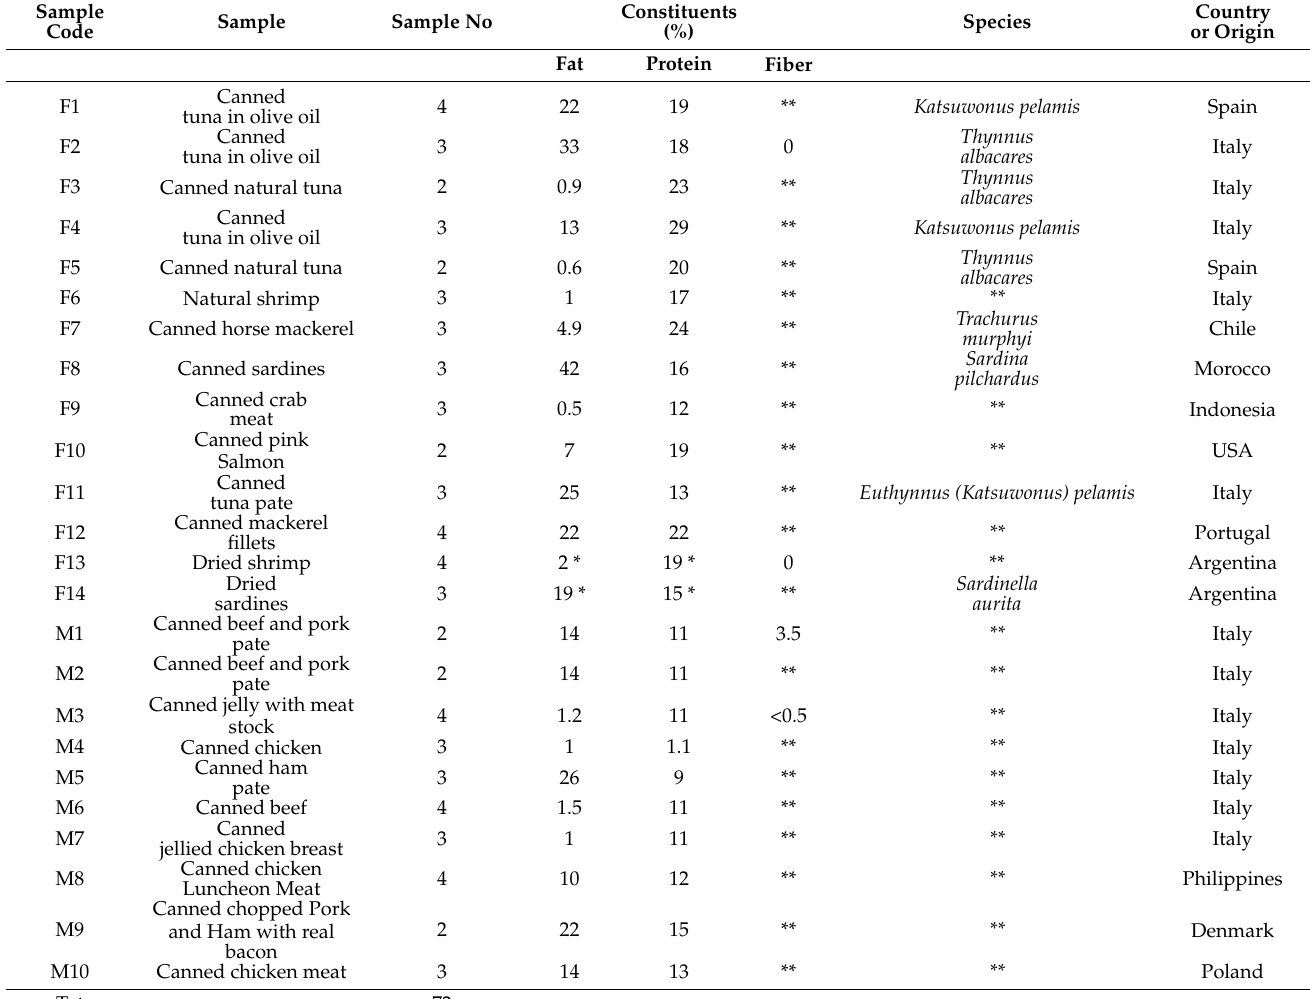
Table 1. Characteristics of processed foods investigated in this